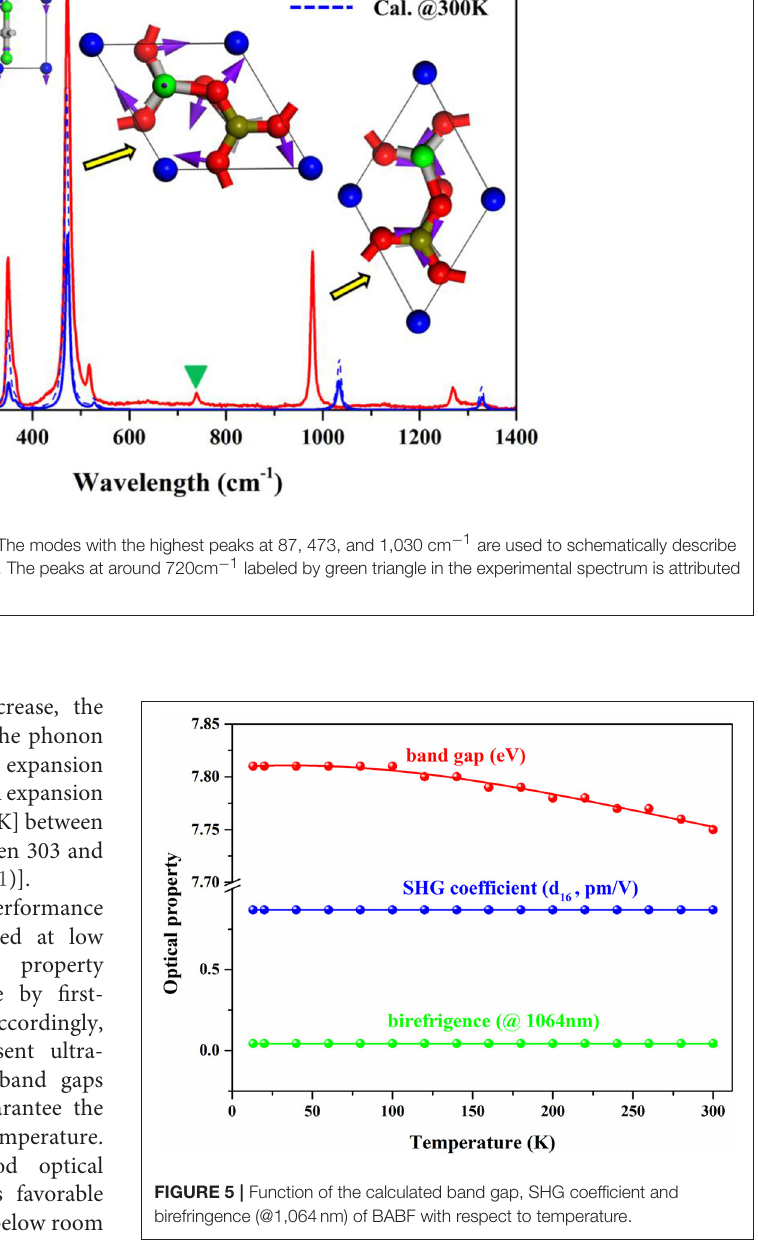
temperature-dependent crystal structure, Raman spectrum